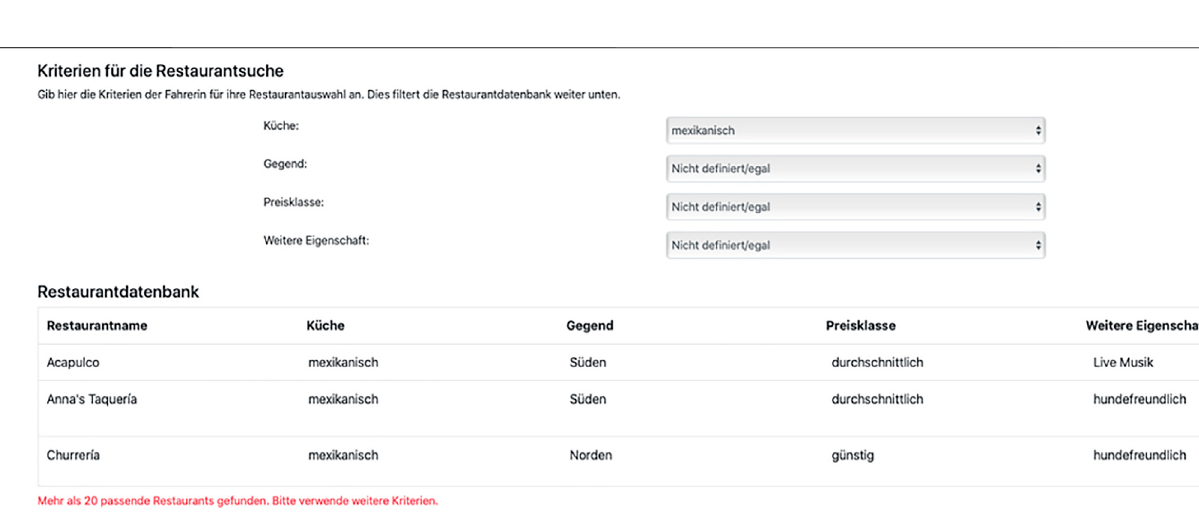
Frontiers in Computer Science |